Question: Identify the chart type used in this figure.
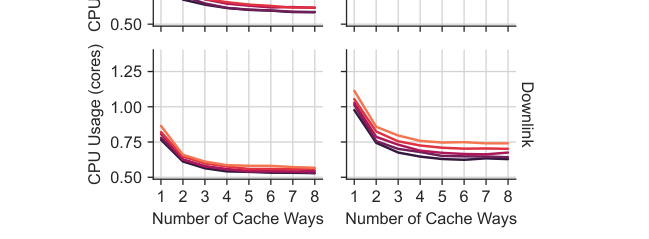
Answer: line